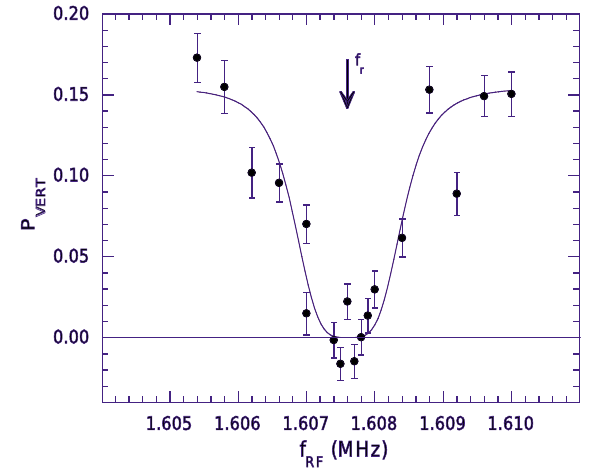
FIG. 3. (Color) The measured vertical proton polarization at 202.7 MeV is plotted against the rf dipole’s frequency. The R B dl was 0.06 T mm. The curve is a fit using a rf dipole’s second-order Lorentzian.